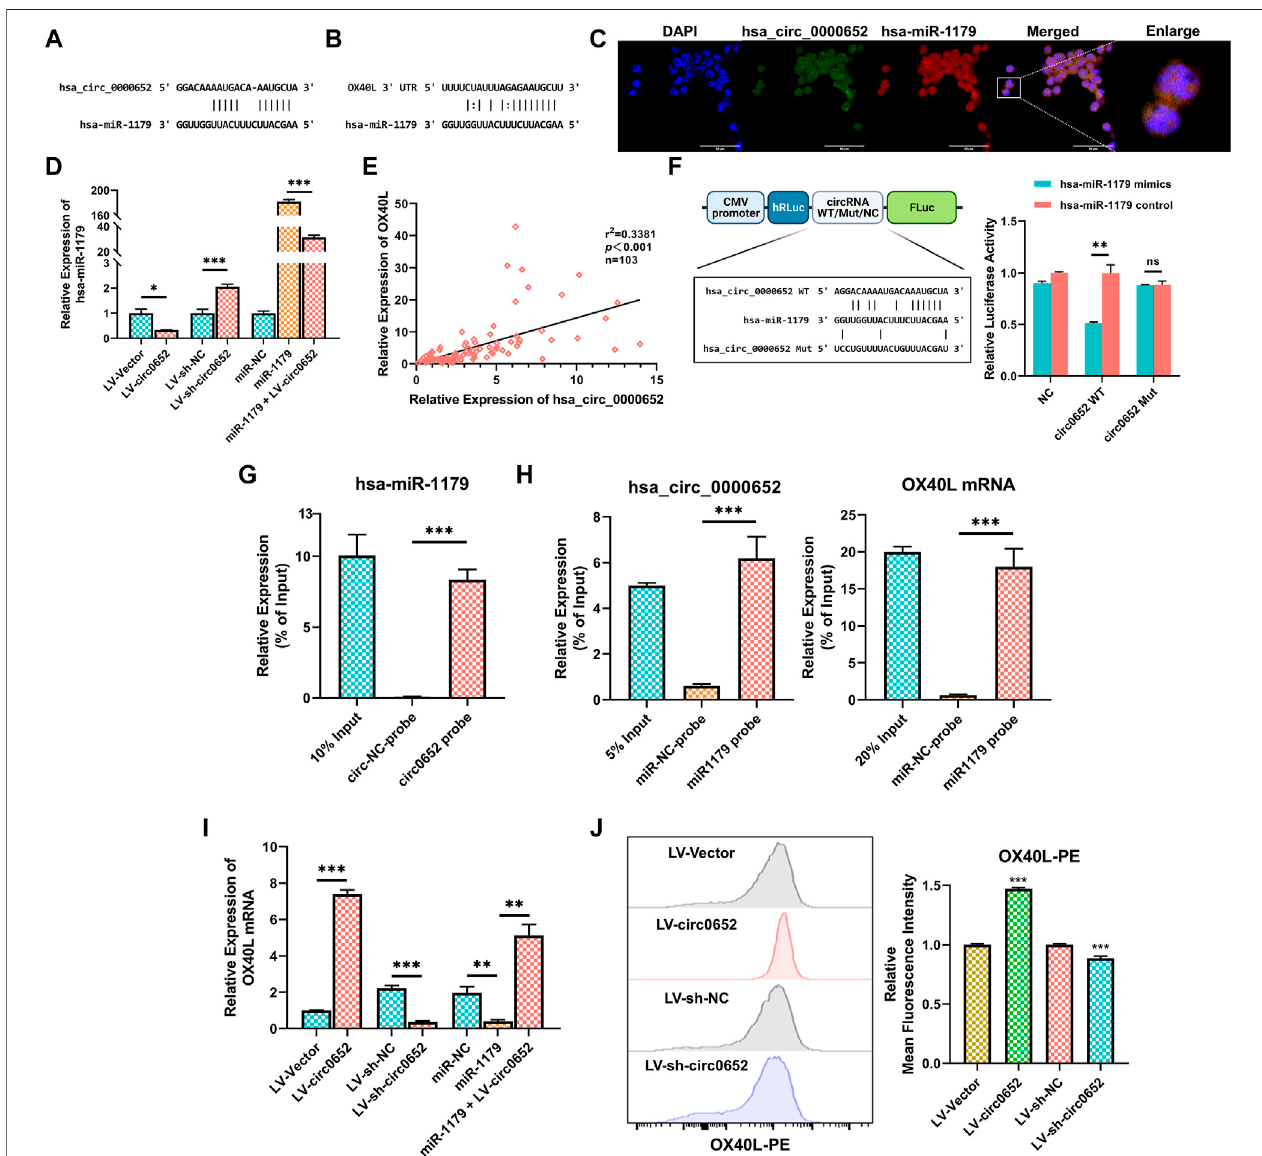
FIGURE 4 | Hsa_circ_0000652 upregulates OX40L expression by sponging hsa-miR-1179. (A – B) Binding sites of hsa_circ_0000652 and hsa-miR-1179 and 3 ′ UTRofOX40LmRNAandhsa-miR-1179predictedbycircInteractome,TargetScan,andMiRandaplatforms. (C) Co-localizationanalysisofhsa_circ_0000652andhsa- miR-1179 in THP-1 – derived macrophages by fl uorescence in situ hybridization (FISH) assay. (D) Quantitative real-time PCR (qRT-PCR) analysis of hsa-miR-1179 in hsa_circ_0000652 stably expressed THP-1 cells and THP-1 transfected with the hsa-miR-1179 mimic or negative control (n (cid:2) 3). (E) Correlation analysis for hsa_circ_0000652 and OX40L mRNA in PBMCs from AS patients and healthy controls (n (cid:2) 103). (F) Dual-luciferase assay detected the binding between hsa_circ_0000652 and hsa-miR-1179. (G) qRT-PCR analysis of hsa-miR-1179 in the immunoprecipitates of RNA immunoprecipitation (RIP) assay using probes for hsa_circ_0000652 or the negative control (n (cid:2) 3). (H) qRT-PCR analysis of hsa_circ_0000652 and OX40L mRNA in the immunoprecipitates of RIP assay using probes for hsa-miR-1179 or the negative control (n (cid:2) 3). (I) QRT-PCR analysis of OX40L in hsa_circ_0000652 stably expressed THP-1 cells and THP-1 transfected with hsa- miR-1179 mimic or the negative control (n (cid:2) 3). (J) Flow cytometry analysis of OX40L on hsa_circ_0000652 stably expressed THP-1 cells (n (cid:2) 3). Data in bar plots are presented as mean ± SD. * p < 0.05; ** p < 0.01; *** p < 0.001.